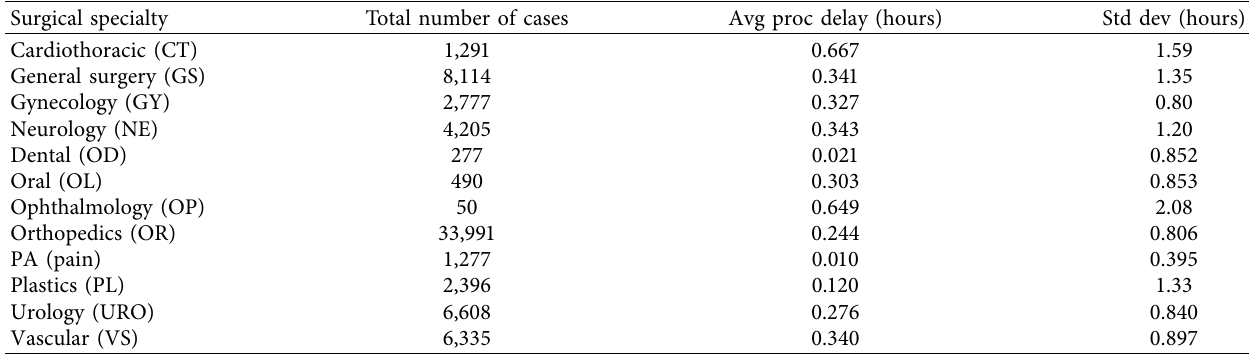
Table 1: Summary statistics of procedure delays by surgical specialty.